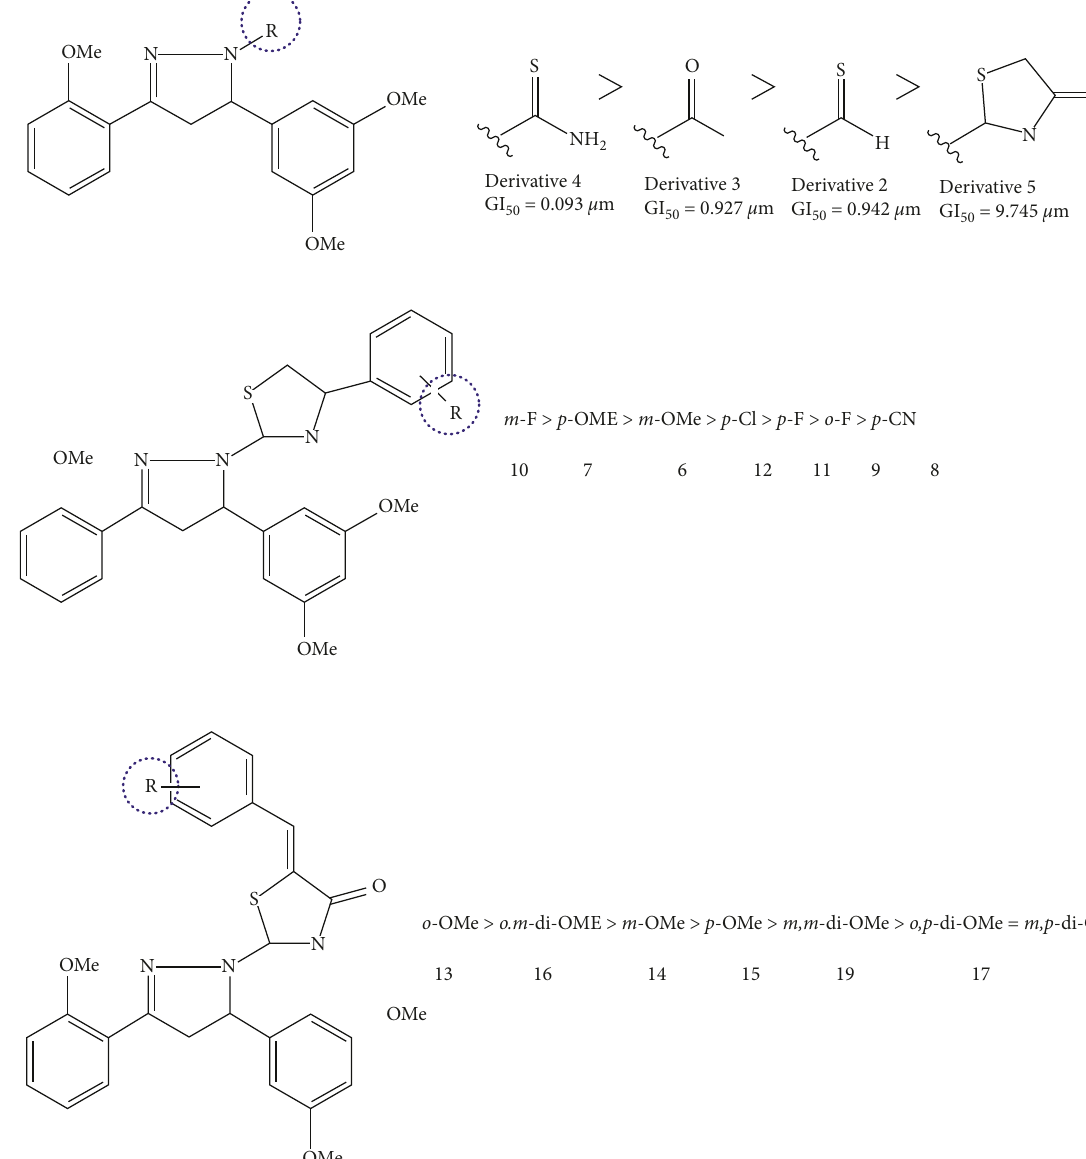
Figure 4: Structures of the 3,5-diphenyl-2-pyrazoline derivatives and their GI